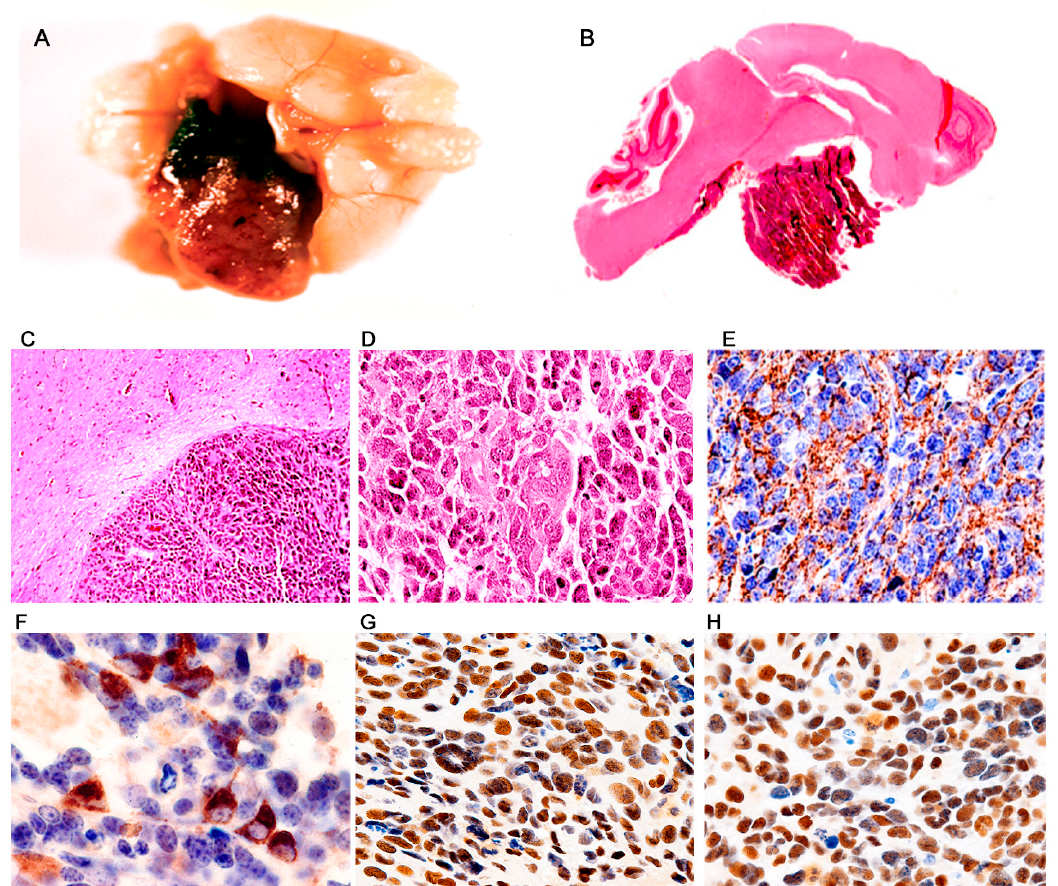
Figure 5. Pituitary tumors; histological and immunohistochemical characterization. Macroscopically, pituitary tumors were large, well circumscribed, solid, brown, masses located in the diencephalic area (Panel ( A )). Montage showing the extra ‐ axial homogeneous tumor with a prominent vascular network (Panel ( B )). Low power view of a well ‐ circumscribed, extra ‐ axial neoplasm, which does not infiltrate the brain parenchyma (Panel ( C ), H&E, original magnification ×100). At higher magnification the tumor is composed of numerous pleomorphic cells with irregular nuclei and abundant eosinophilic cytoplasm. Giant multinucleated cells are present (Panel ( D ), H&E, original magnification ×400). Immunohistochemistry for chromogranin shows extensive cytoplasmic expression in neoplastic cells (Panel ( E ), original magnification ×200). Occasionally, neoplastic cells showed robust immunoreactivity for prolactin (Panel ( F ), original magnification ×400). Expression of the JCPyV early product, T ‐ Antigen was found in the nuclei of numerous neoplastic cells, including giant multinucleated cells (Panel ( G )), and p53 was also detected in the nuclei of tumor cells (Panel ( H ), both panels original magnification ×400).